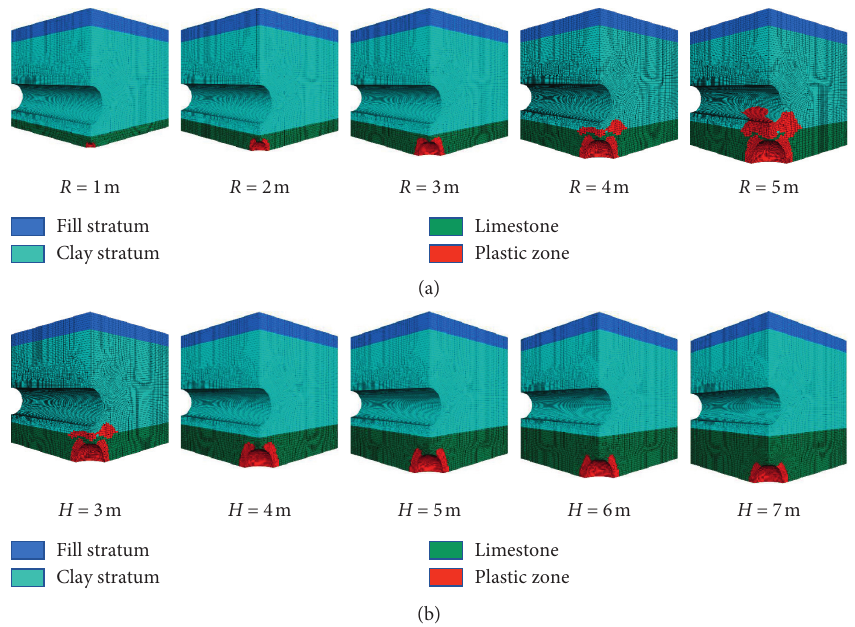
Figure 15: Development law of the plastic zone under different sizes (a) and locations (b) of the karst